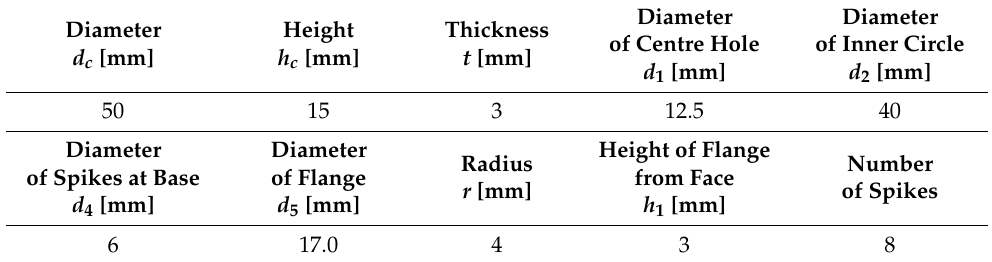
Table 7. Dimensions of C11 (Geka) connectors 1 (connector type: C11-50/M12) [41].